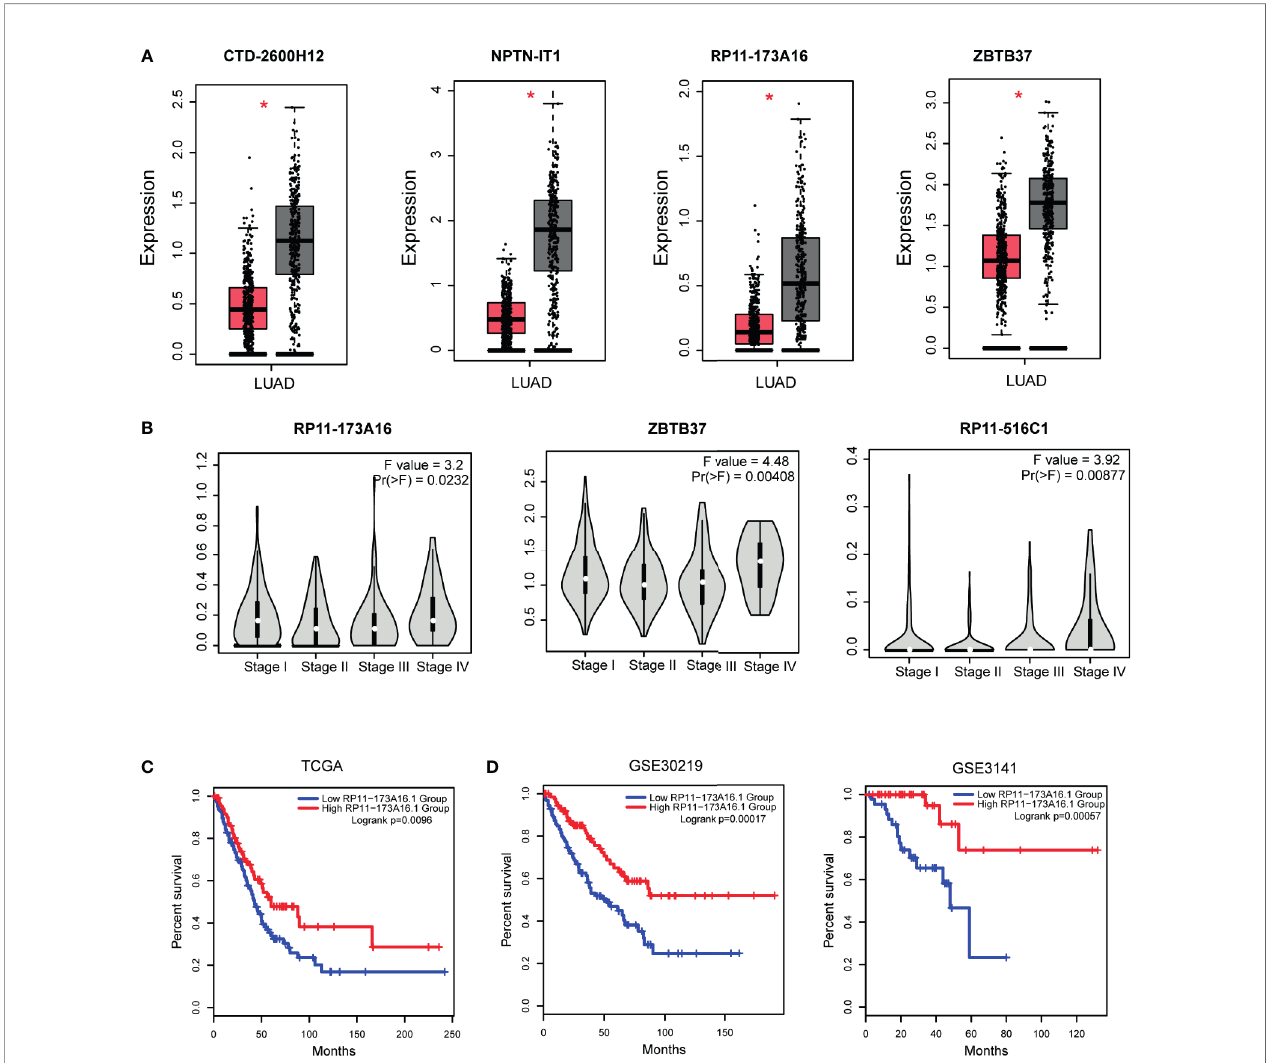
FIGURE 3 | Expression and clinical value of hub genes. (A) The expression patterns of one TF hubs (ZBTB37) and three lncRNA hubs (CTD-2600H12, NPTN-IT1, and RP11-173A16) with the highest degrees in TCGA LUAD cohorts. (B) Three hub genes (RP11-173A16, RP11-516C1, and ZBTB37) were selected to detect their expression in different stages of lung adenocarcinoma. (C) The prognostic effect of hub lncRNA RP11-173A16 in TCGA cohorts. (D) The prognostic effects of hub lncRNA RP11-173A16 in other two independent validation cohorts. *represents p < 0.05, tumor vs control group